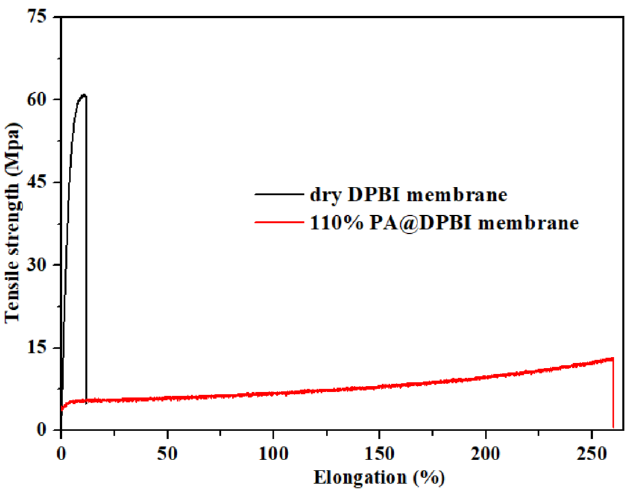
Figure 2. Stress-strain curves of the dry and PA doped DPBI with 110% ADC. Table 1. Proton conductivities and mechanical properties of PA undoped DPBI and DPBI mem- branes with ADC around 100%.